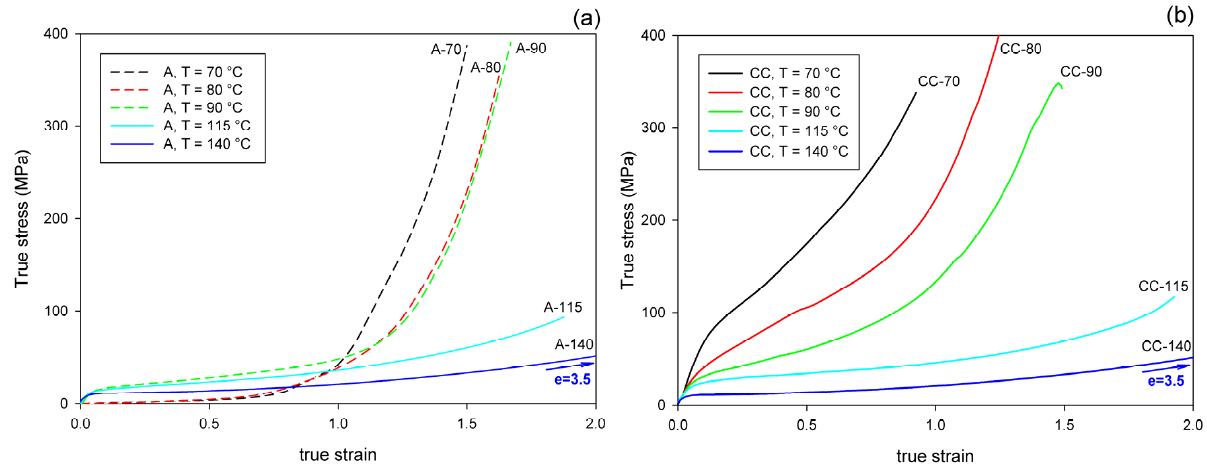
Figure 5. True stress–true strain curves of samples deformed by plane-strain compression in a channel-die at temperatures indicated. ( a ) Amorphous samples, A; ( b ) cold crystallized samples, CC.